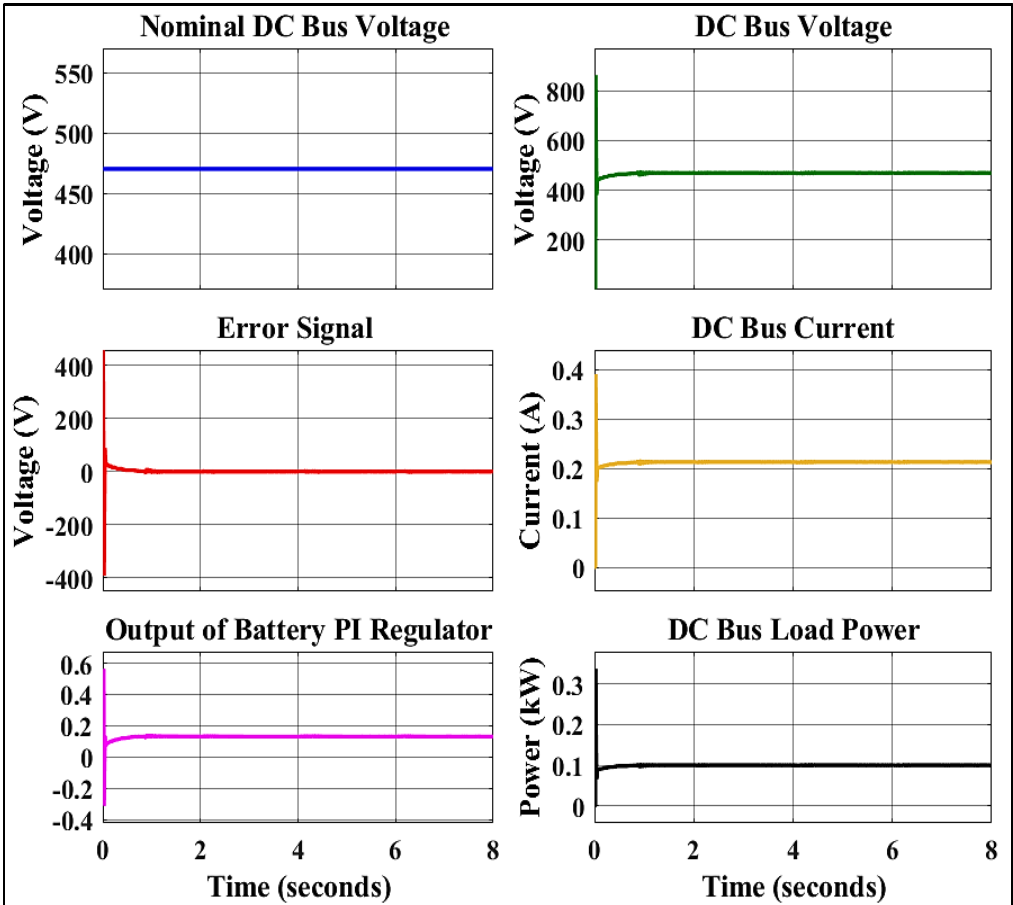
Figure 10. DC bus readings measured with input and output of the PI controller in (Scenario 1).